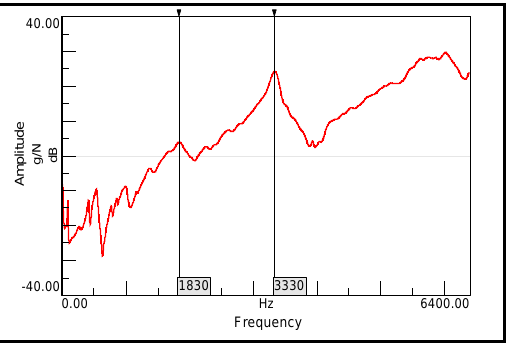
Figure 7. FRF from impact hammer test in the axial direction on the shaft side housing face.